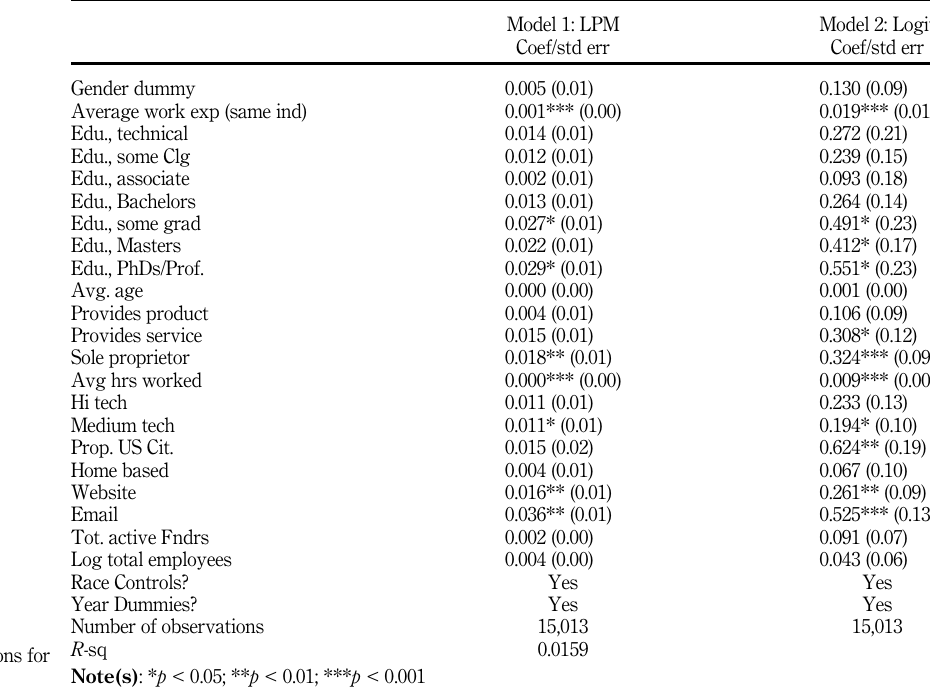
Table 1. Pooled regressions for